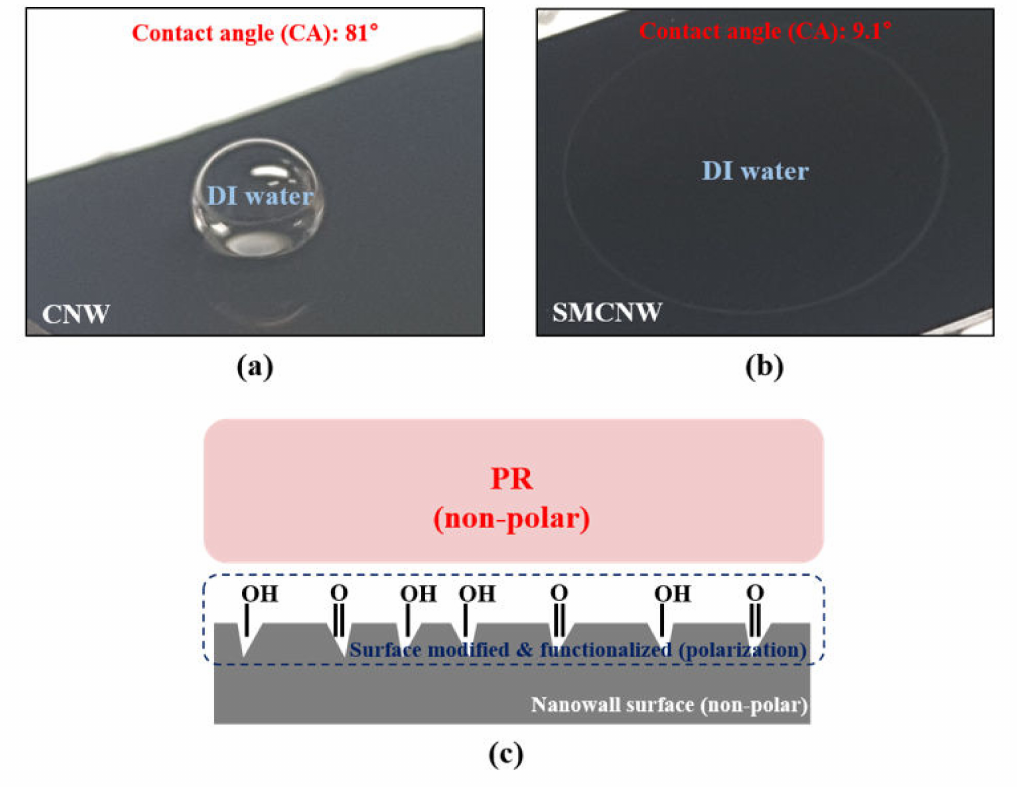
Figure 4. Contact angle of the ( a ) CNW and ( b ) surface-modified carbon nanowall (SMCNW). ( c ) Schematic of the positive PR-coated